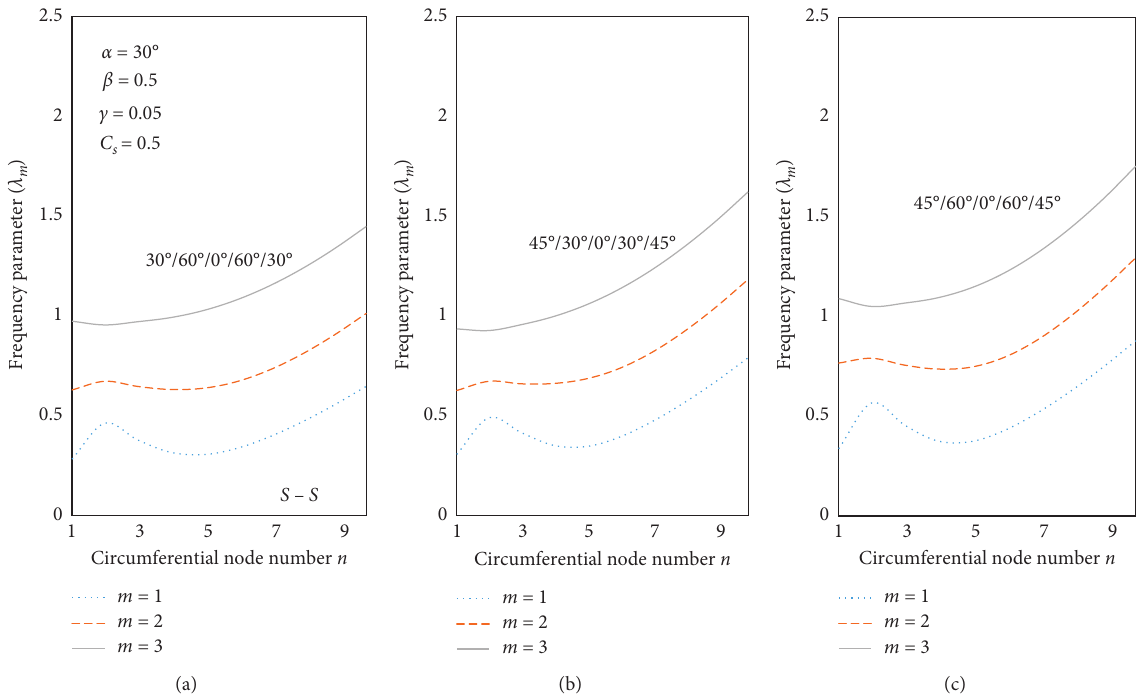
Figure 16: Influence of circumferential node number on the frequency parameter of five-layered conical shells with KE/EGE/GE/EGE/KE material